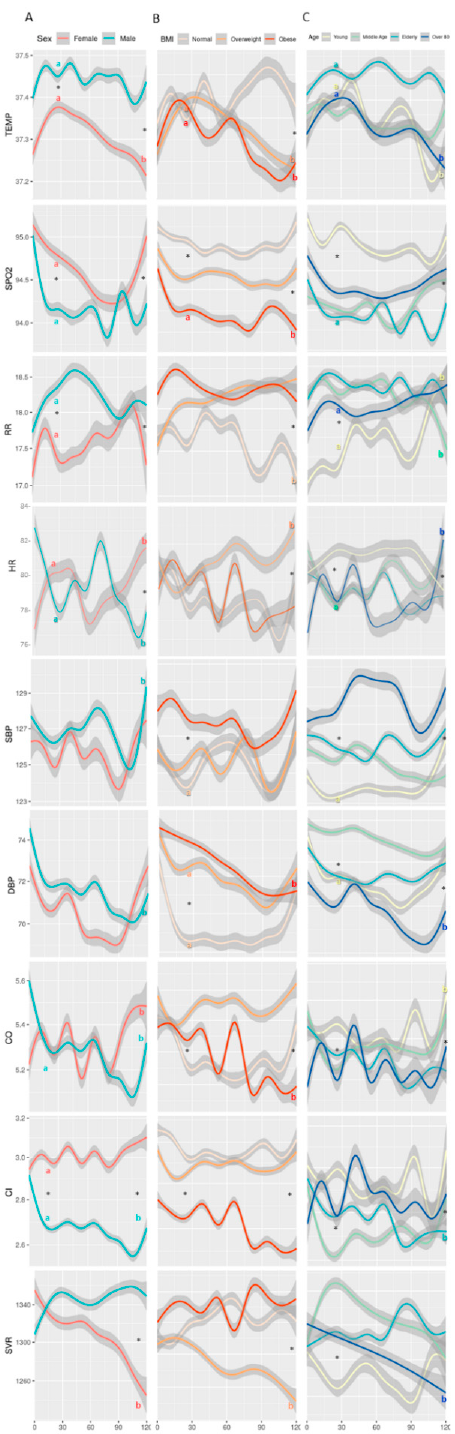
Figure 4. Measured vital signs by ( A ) sex, ( B ) BMI, and ( C ) age group, over the course of the first 5 days of tracking. Definitions of BMI and age groups are provided in Figure 2. Temp, temperature; SpO 2 , blood oxygen saturation; RR, respiratory rate; HR, heart rate; SBP, systolic blood pressure; DBP, diastolic blood pressure; CO, cardiac output; CI, cardiac index; SVR, systemic vascular resistance. Each line represents mean values of the vitals, and the 95% confidence interval appears in gray. * Significant ( p < 0.05) difference between groups for a given time-point; a significant ( p < 0.05) difference between 24 h and baseline within a group; b significant ( p < 0.05) difference between 120 h and baseline within a